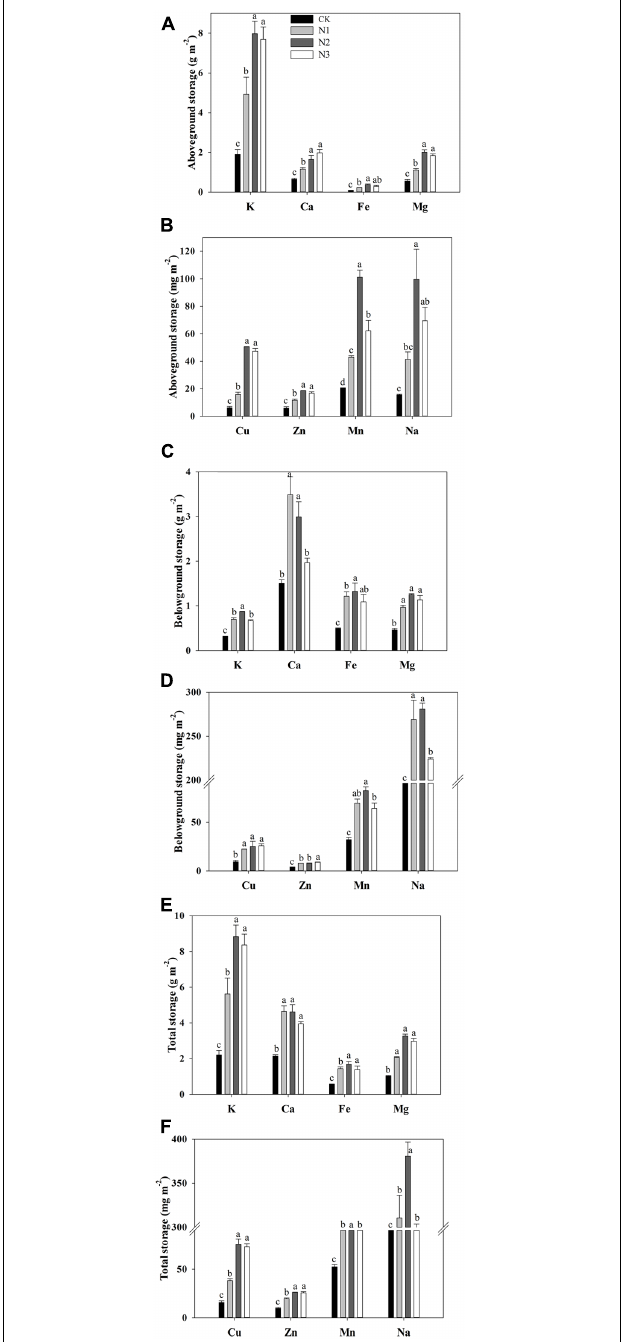
FIGURE 3 | Effects of N addition on plant biomass macro- and micronutrient storage of B. ischaemum . (A) The storage of K, Ca, Fe, and Mg in the aboveground biomass of B. ischaemum . (B) The storage of Cu, Zn, Mn, and Na in the aboveground biomass of B. ischaemum . (C) The storage of K, Ca, Fe, and Mg in the belowground biomass of B. ischaemum . (D) The storage of Cu, Zn, Mn, and Na in the belowground biomass of B. ischaemum . (E) The total of K, Ca, Fe, and Mg in the biomass of B. ischaemum . (F) The total storage of Cu, Zn, Mn, and Na in the biomass of B. ischaemum . Error bars represent SE ( n = 3). Different letters above the bars indicate a significant difference at P = 0.05.